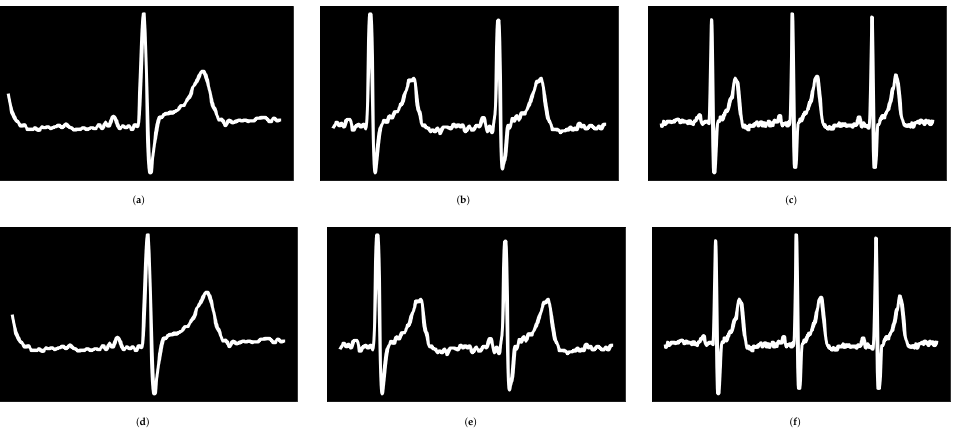
Figure 3. ( a – f ) are the pair of ECG beats from the same and different persons to train the Siamese network. (( a – c ) are for subject-1 ECG data, rest of for subject-2 ECG data).